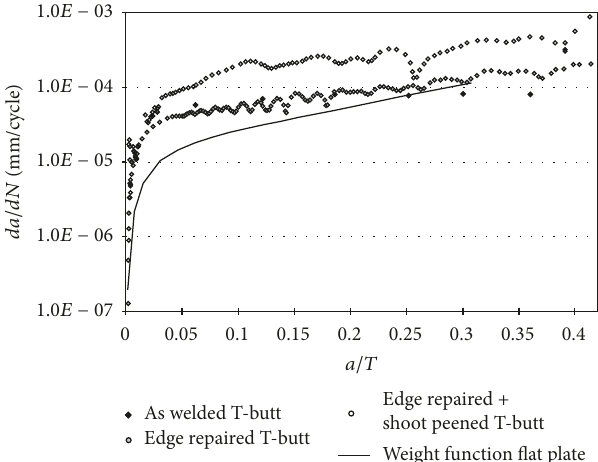
Figure 9: 𝑑𝑎/𝑑𝑁 versus crack depth for fatigue tested specimens.